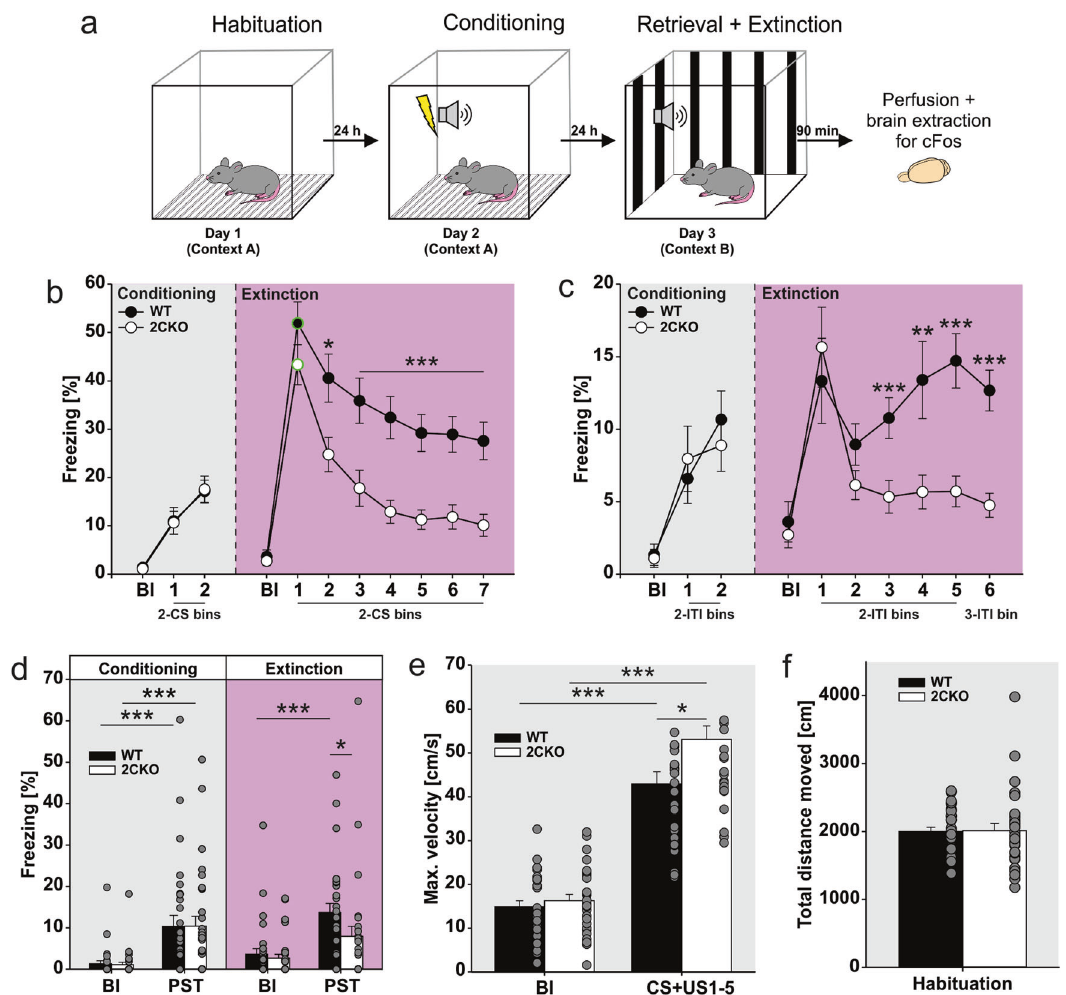
Fig. 1 Constitutive 5-HT2CR knock-out facilitates fear extinction. a Schematic representation of the experimental paradigm. b Freezing behavior during conditioning (day 2) and extinction (day 3) session in respect to conditioned stimulus (CS) time bins and baseline (Bl) period. Circles outlined in green re fl ect the fear retrieval test (averaged freezing to the fi rst two CS of the extinction session). 2CKO mice showed less CS-freezing during extinction: Mann – Whitney Rank Sum test (WT vs. 2CKO); bin2(CS): P = 0.023, bin3(CS): P = 0.001, bin4 – bin7(CS): P ≤ 0.001. c Freezing behavior during conditioning (day 2) and extinction (day 3) session in respect to inter-trial interval (ITI) time bins and baseline (Bl) period. 2CKO mice showed less ITI-freezing during extinction: Mann – Whitney Rank Sum test (WT vs. 2CKO); bin3(ITI): P = 0.001, bin4(ITI): P = 0.009, bin5 – 6(ITI): P ≤ 0.001. d Comparison of baseline (Bl) and post-stimulus time (PST) freezing during conditioning (day 2) and extinction (day 3) session. Conditioning procedure increased freezing in both genotypes: Wilcoxon Signed Rank test (Bl vs. PST); WT: P ≤ 0.001, 2CKO: P ≤ 0.001. WT mice showed higher freezing in extinction PST: Wilcoxon Signed Rank test (Bl vs. PST); WT: P ≤ 0.001. Mann – Whitney Rank Sum test (WT vs. 2CKO); PST: P = 0.011. e Maximum movement velocity as unconditioned stimulus (US, foot shock) reactivity. Movement